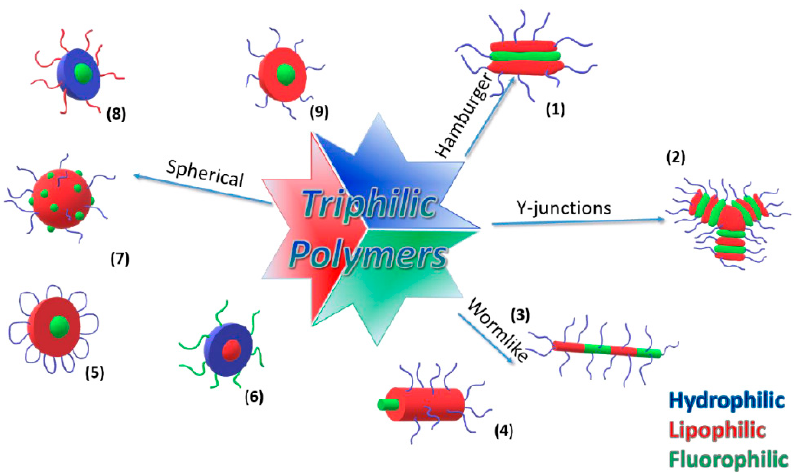
Figure 2. The diversity of possible micellar aggregates of triphilic polymers in aqueous solution. (1)—